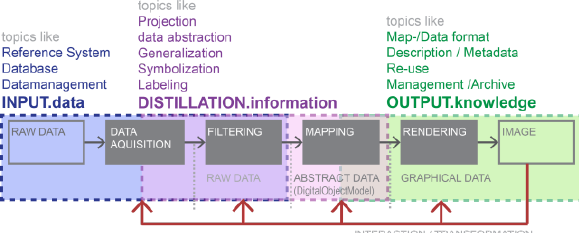
Figure 2 Visualization Pipeline linked to the process during planetary mapping and the data-information-knowledge-wisdom hierarchy (see 1.2 and Figure